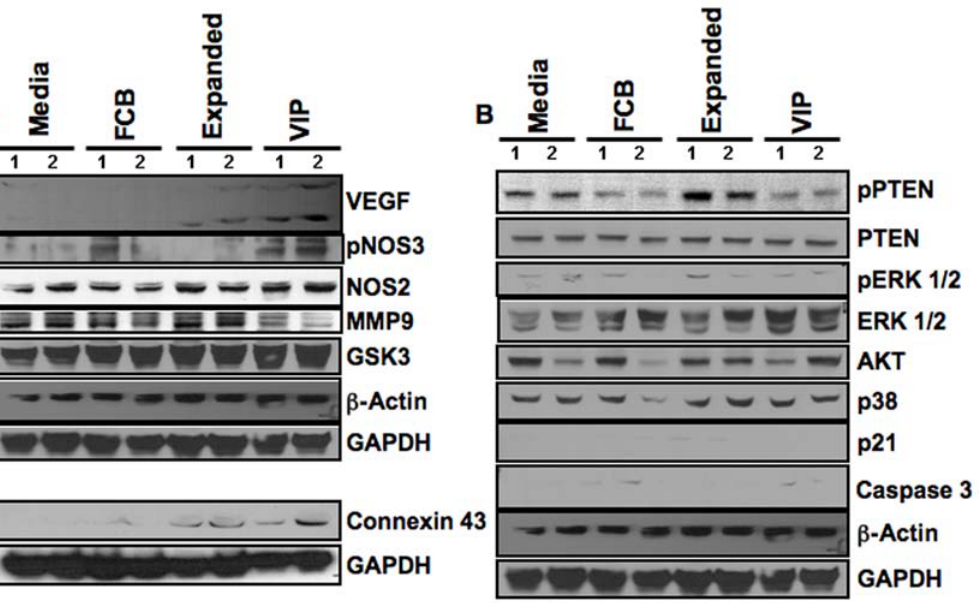
Figure 7. Expression of signaling molecules. (A) Western blot of angiogenesis related and connexin 43 proteins from each animal group. (B) Western blot of various molecules of oncogenic potential and relevant signaling pathways from each animal group.